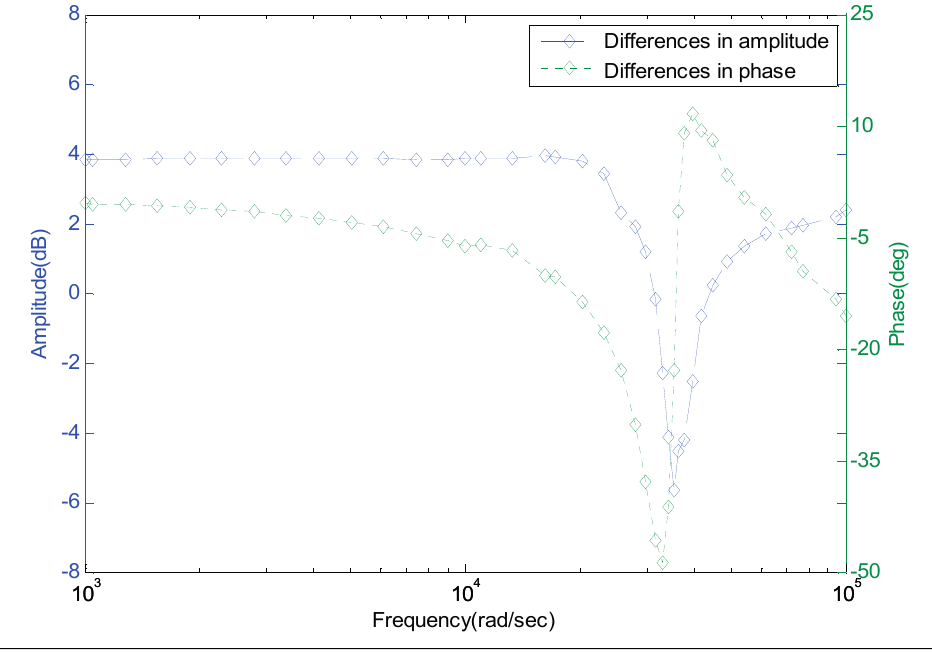
Figure 15. Differences in the amplitude-frequency and phase-frequency between the frequency-domain experiment and Model